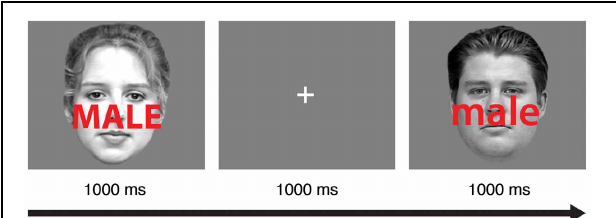
FIGURE 1 | A schematic of the experimental task. In each trial, subjects were instructed to discriminate the gender of the face image (male or female) while ignoring the gender of the superimposed word (male or female). In this sample trial sequence, an incongruent stimulus in one trial (left) is followed by a congruent stimulus in the subsequent trial